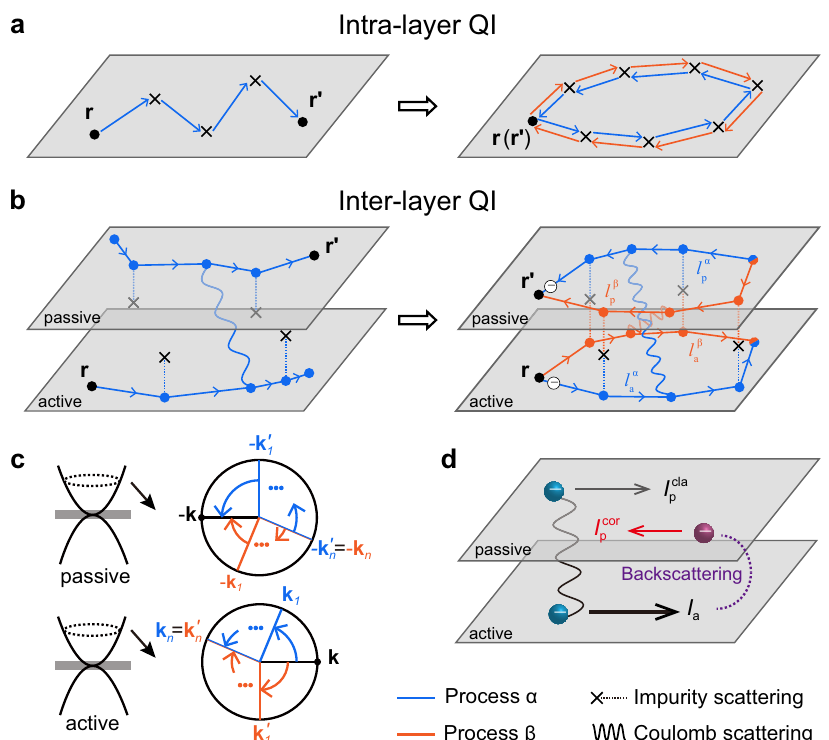
Fig. 3 | Quantum interference (QI) in Coulomb drag. a Intra-layer QI. Left panel: Schematic of an ordinary diffusion path from position r to r 0 . Right panel: Intra- layerQIoccurring between a pair of time-reversedclosed loops with r = r 0 . b Inter- layer QI. Left panel: Schematic of a typical drag process, which describes how an activecarrieratposition r inducesapassivecarriermovingtoward r 0 .Here,onlythe impurityscatteringsoriginatingfromtheintermediatehBNspacerareshown.Right panel: Inter-layer QI between two drag processes (process “ α ” and “ β ” ) in the e-e